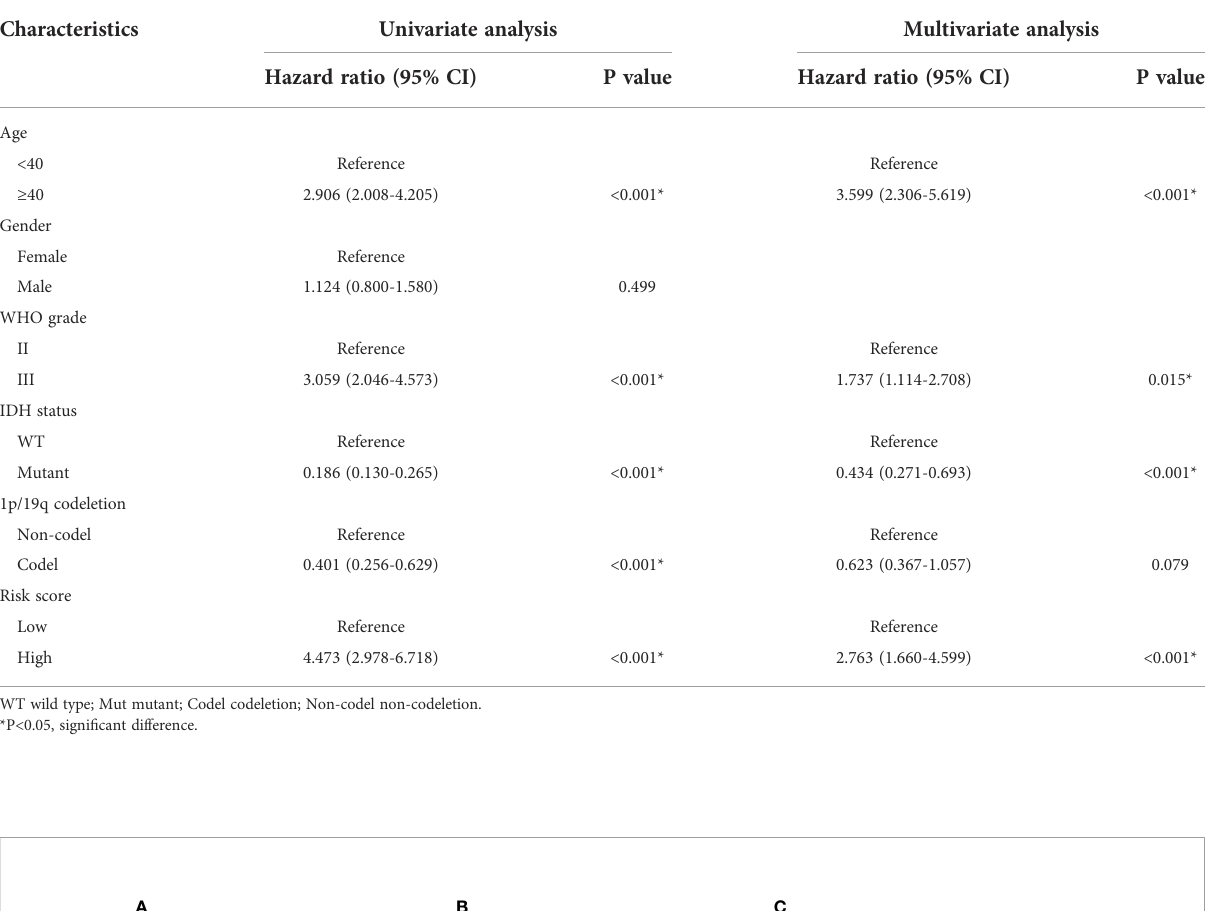
TABLE 2 Univariate and multivariate Cox regression analyses in LGGs.